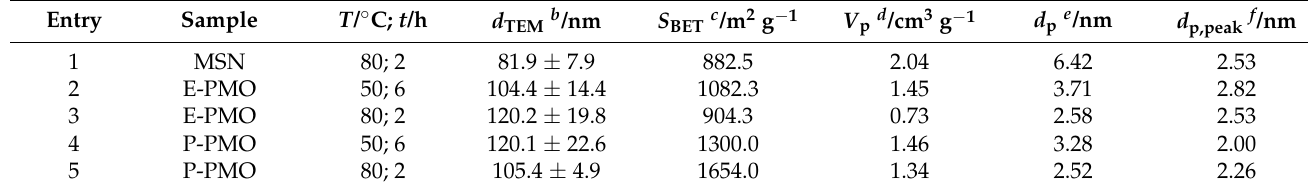
Table 1. Synthetic conditions and pore parameters of siliceous NPs under study a